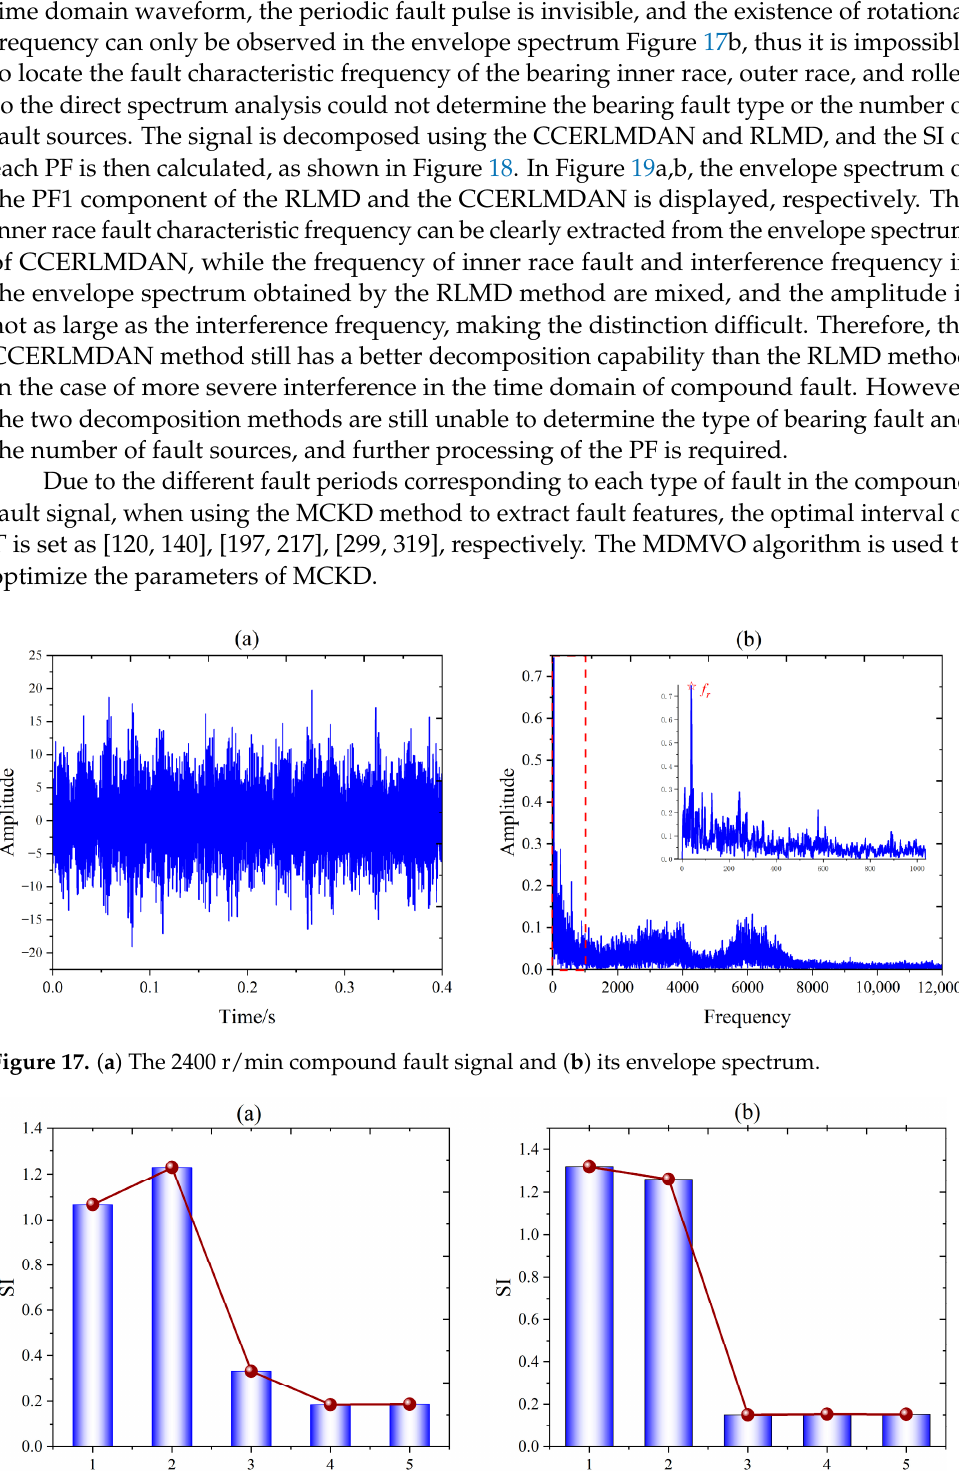
Figure 18. The SI value for each PF were calculated by processing the compound fault signal at 2400 r/min: ( a ) RLMD and ( b ) CCERLMDAN.